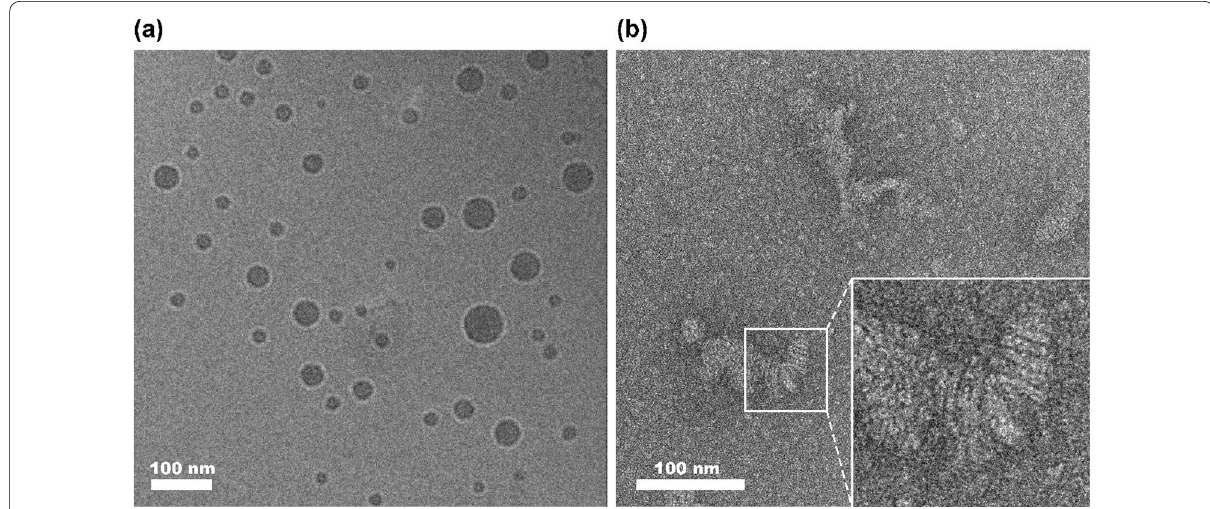
Fig. 3 TEM image of synthesized assemblies. a vesicles were synthesized at [DMPC] [DMPC] 100 mM, [DHPC] 20 = =